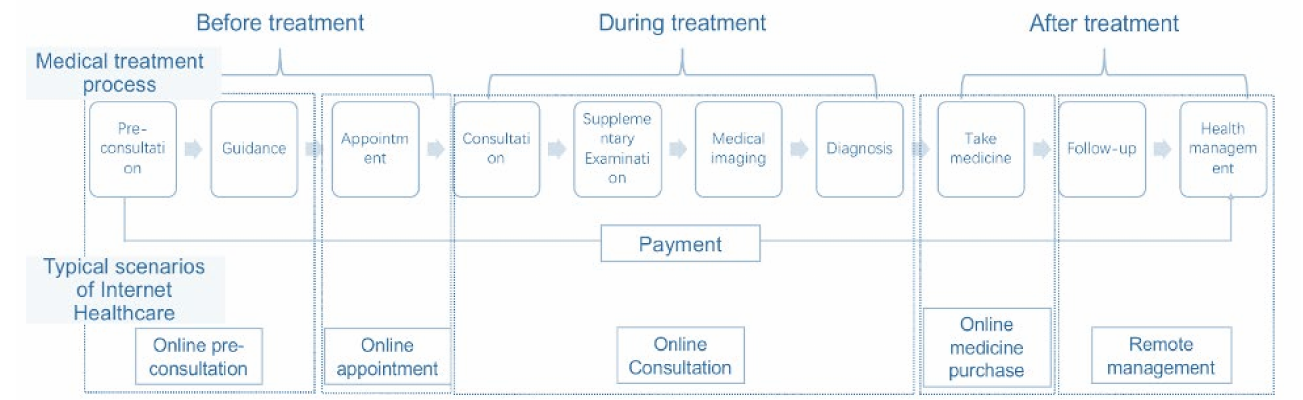
Figure 3. The medical treatment process in the physical hospital and online method. Adapted from source: Xinhua.net [20]).